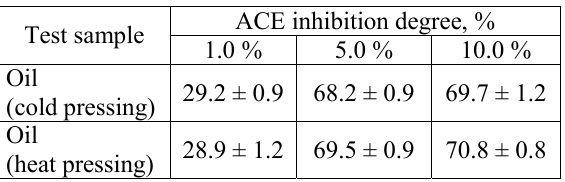
Fig. 7. Results of in vitro determination of the antioxidant effect of cedar oil on the cultured MDCK1 cells for 90 min: (1) oil (cold pressing); (2) oil (heat pressing). The data are expressed as a mean ± standard deviation ( n = 5). Table 2. Results of the determination of the antihypertensive activity of the in vitro oil obtained from pine nut